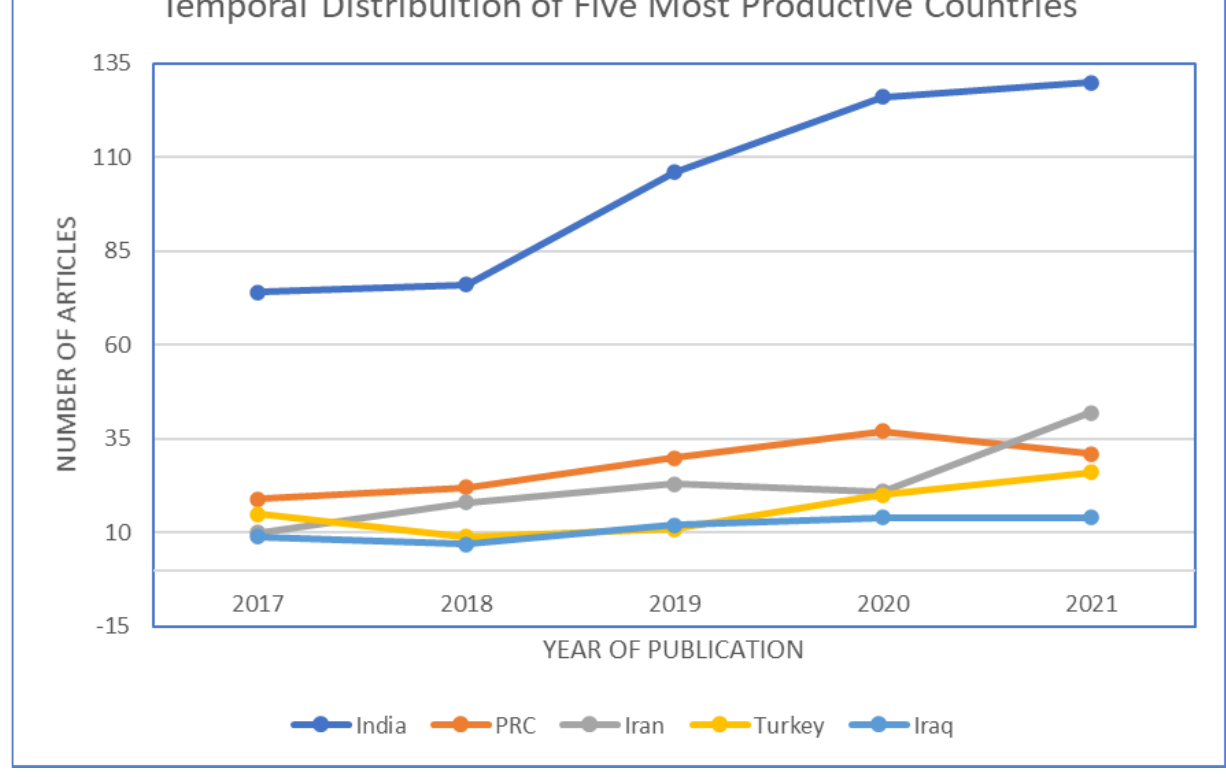
Figure 6. Temporal distribution of the most productive countries in SAHs.